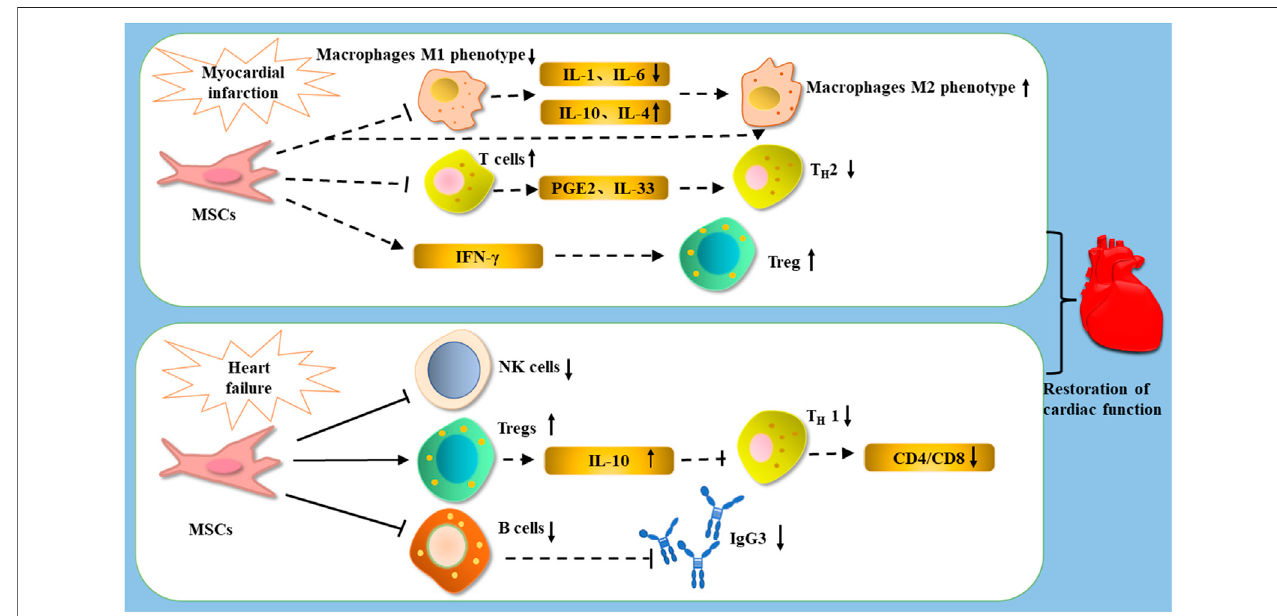
FIGURE 3 | After the occurrence of MI, treated with MSCs, MSCs improve cardiac function by decreasing the expression of IL-1 β and IL-6, increasing the expression ofIL-10andIL-4,andpromotingthepolarizationofmacrophagesfromM1phenotypetoM2phenotype;theycanimprovecardiacfunctionbypromotingthe expression ofTregs toenhance cardiac function, aswell asinhibiting Tcells and in fl uencing the differentiation ofTh1cells through PGE2 and IL-33.Afterthe occurrence ofheartfailure,treatment withMSCscanrestorecardiac functionbyreducingthenumberofNKcells, inhibiting theproliferation ofBcellsand theproduction ofthe antibody IGg3, as well as increasing the number of Tregs and reducing the CD4/CD8 ratio by reducing Th1 cells through IL-10.